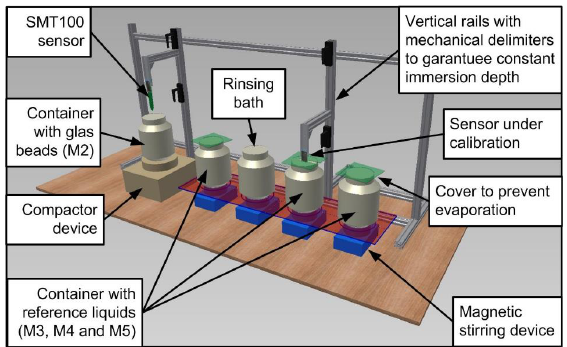
Figure 2. Schematic drawing of the calibration station.